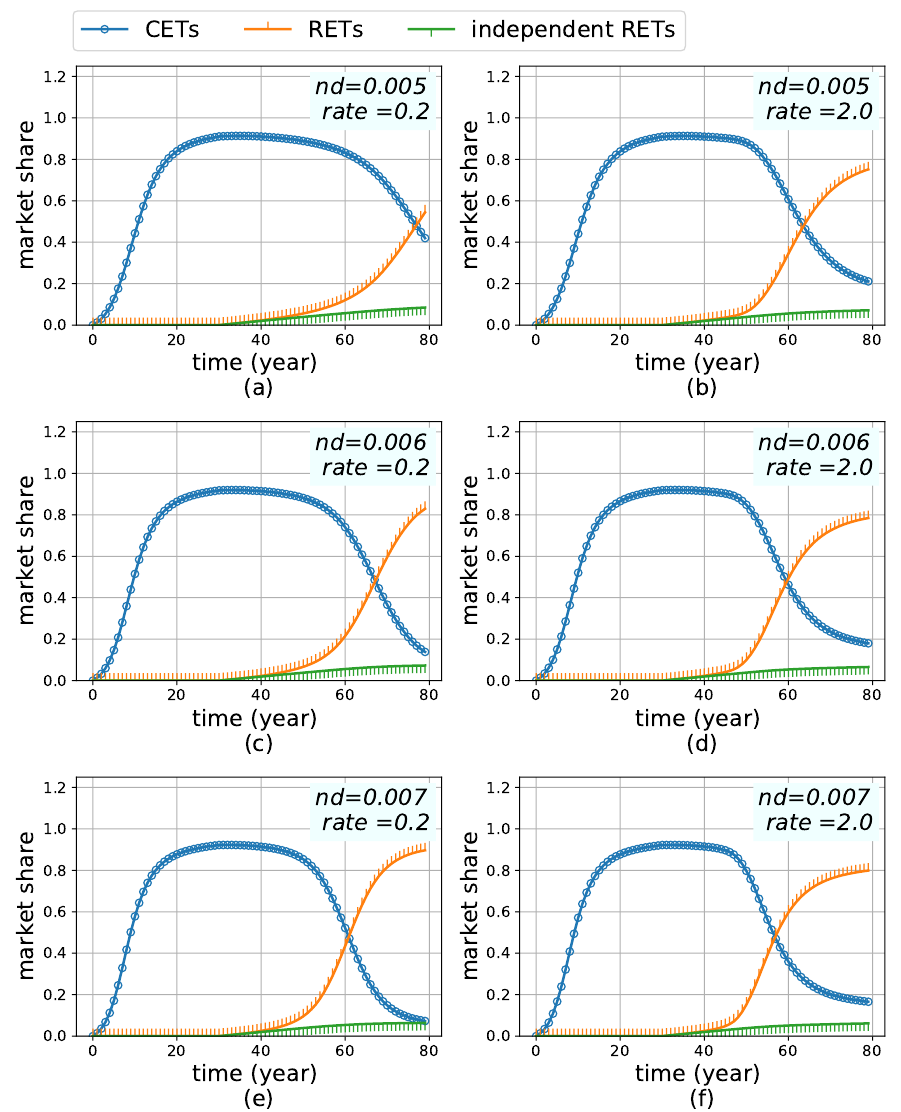
Figure 12. The joint impact of network density and RET improvement